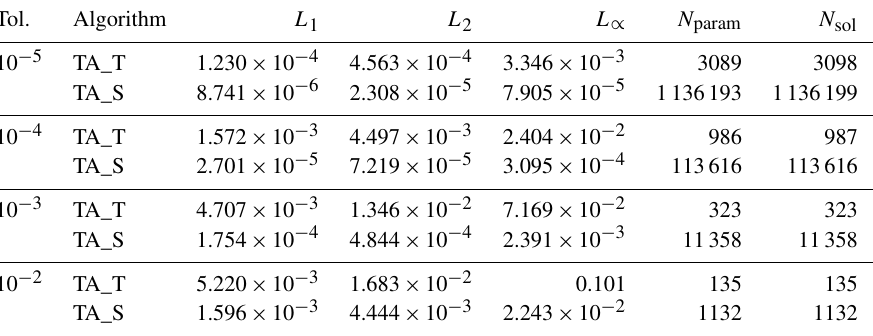
Table 6. Relative errors and number of iterations obtained for the time-adaptive algorithm depending on different convergence criteria for TC2.